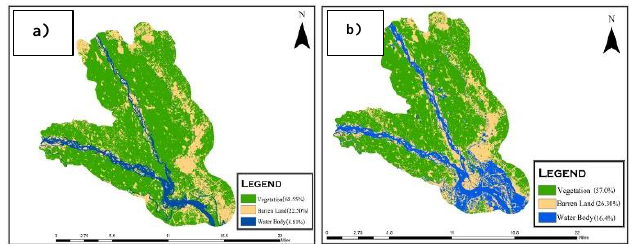
Figure 4: (a) Classified map of the study area shows the distribution of different land covers across the study area before the flood, while (b) reveals post classified map of study area showing land